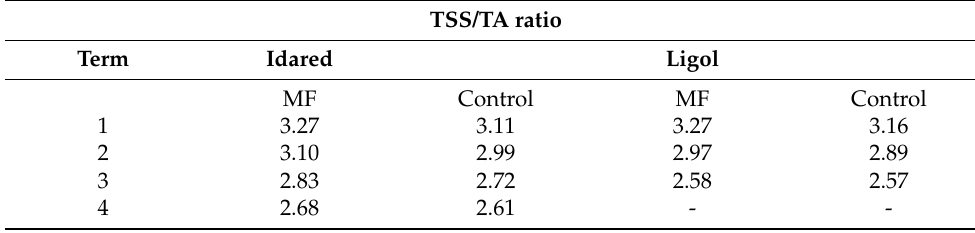
Table 3. Values of the TSS/TA ratio of MF-treated and control apples for each